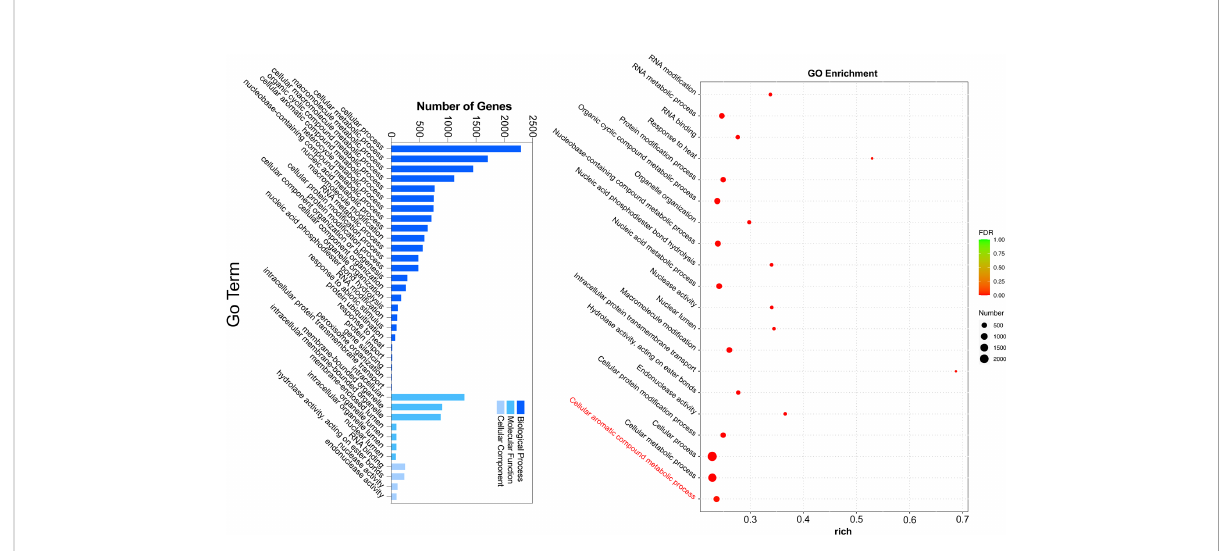
FIGURE 6 GO functional enrichment analysis of DEGs in chilled and unchilled melon fruit.